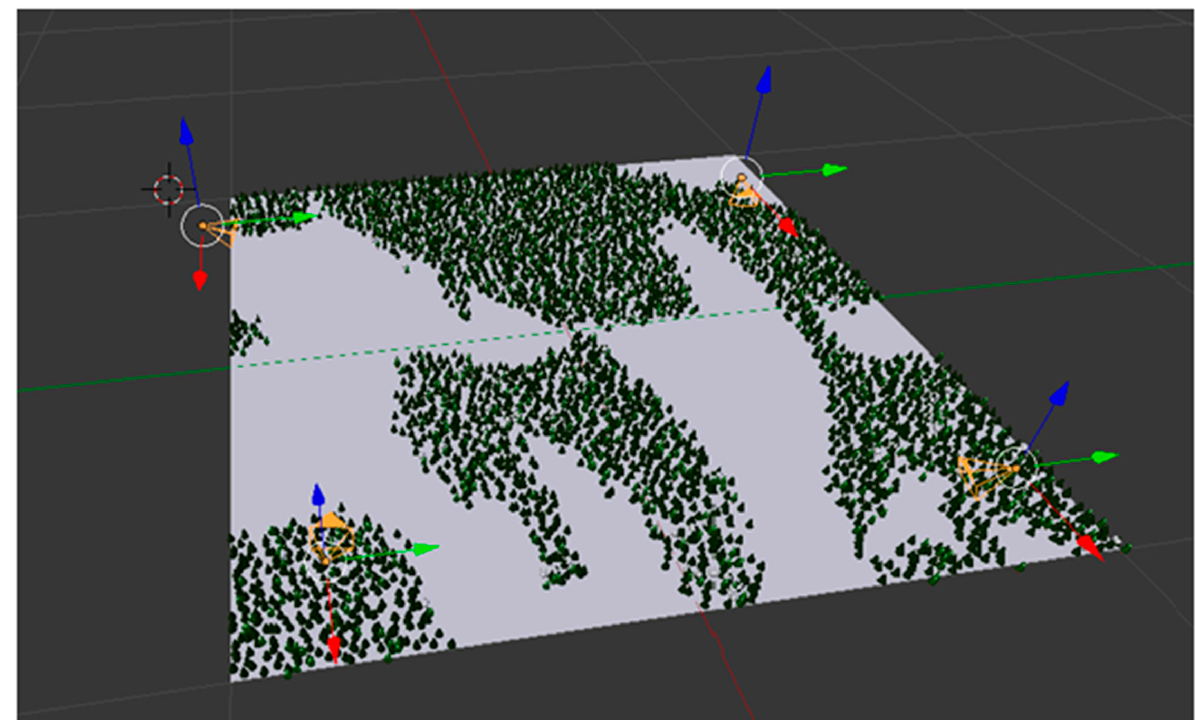
Figure 5. Forest model before the integration of remote sensing